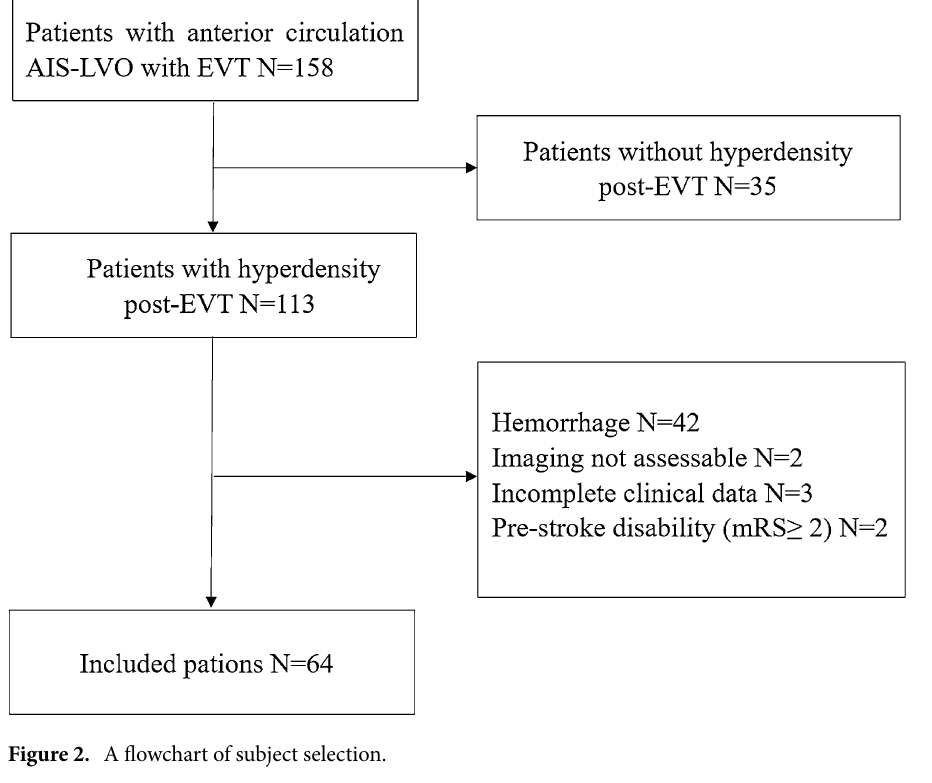
Figure 2. A flowchart of subject